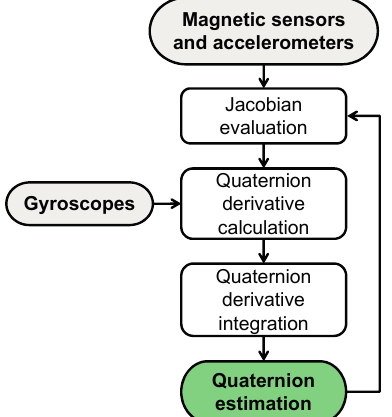
Figure 3. Framework of the CF